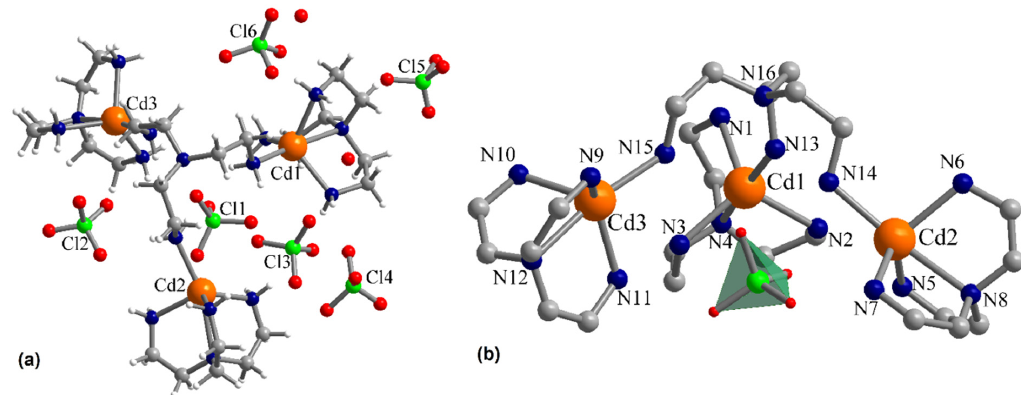
Figure 1. ( a ) View of the asymmetric unit in crystal 1 and ( b ) perspective view of the tripodal trinuclear cation [{Cd(tren)} 3 (tren)] 6+ with the perchlorate anion hosted inside (the hydrogen atoms were omitted for clarity). The equatorial Cd-N bond lengths are: Cd1-N1 = 2.299(7), Cd1-N2 = 2.294(7), Cd1-N3 = 2.277(8), Cd2-N5 = 2.258(8), Cd2-N6 = 2.300(8), Cd2-N7 = 2.310(9), Cd3-N9 = 2.267(10), Cd3-N10 = 2.288(13) and Cd3-N11 = 2.264(14) Å, while the axial Cd-N bond lengths are: Cd1-N4 = 2.430(6), Cd1-N13 = 2.252(6), Cd2-N8 = 2.459(7), Cd2-N14 = 2.282(6), Cd3-N12 = 2.418(8) and Cd3-N15 = 2.282(8) Å. The Cd···Cd distances within the trinuclear complex are: Cd1···Cd2 = 6.67, Cd2···Cd3 = 7.83 and Cd3···Cd1 = 6.77 Å. The trinuclear cations [{Cd(tren)} 3 (tren)] 6+ are organized in layers in the crystallo- graphic ab plane and within one layer the arms of the tripodal cations are orientated in the same direction (Figure 2). Figure 2. View along the crystallographic c axis of a packing diagram in crystal 1. The exposure of the reaction mixture for longer time to atmospheric condition allows the partial replacement of the bridging tren ligands with carbonate anions resulted from the capture of atmospheric CO 2 . Compound 2 , [{Cd(tren)} 3 (tren)][{Cd(tren)} 3 (µ 3 - CO 3 )](ClO 4 ) 10 , crystallizes after more than one week and its structure consists in two types